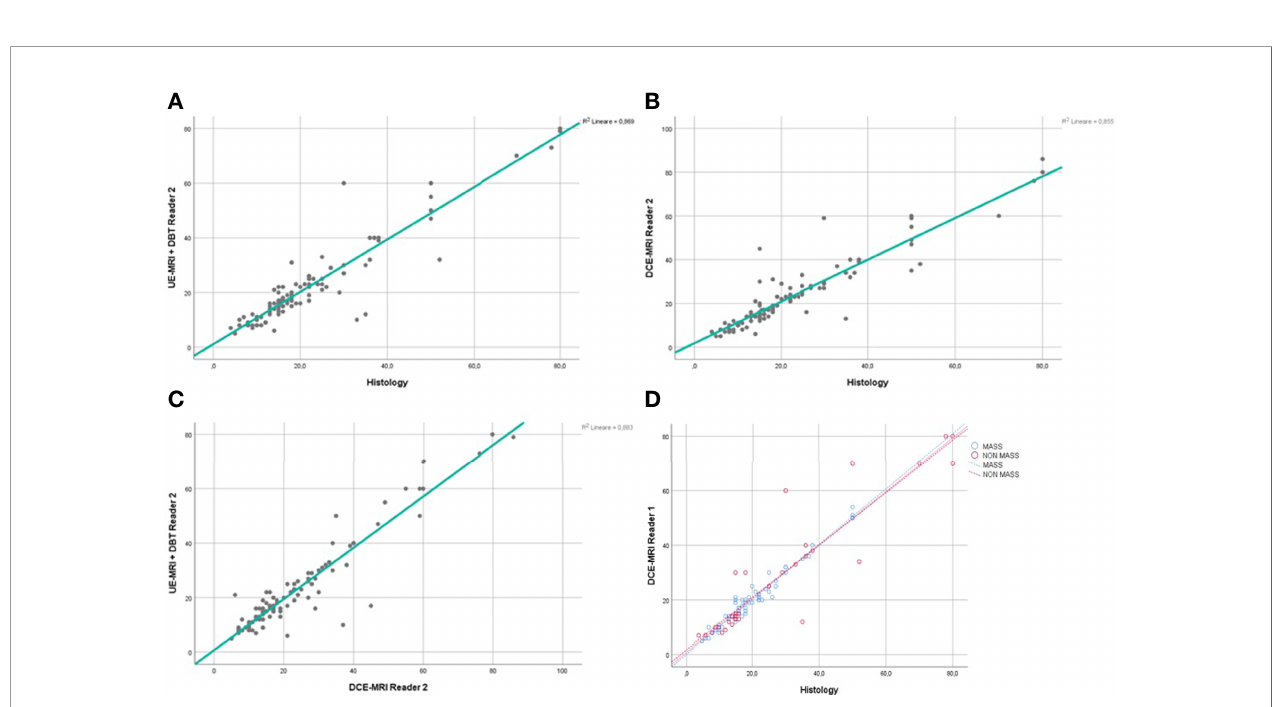
FIGURE 5 | Reader 2 lesions size assessment. Regression analysis for the lesion size, comparing UE-MRI + DBT vs Histology (A) , DCE-MRI vs Histology (B) and UE-MRI+DBT vs DCE-MRI (C) . Section (D) shows the regression analysis performed dividing the lesions into the mass and non-mass groups, comparing DCE-MRI vs